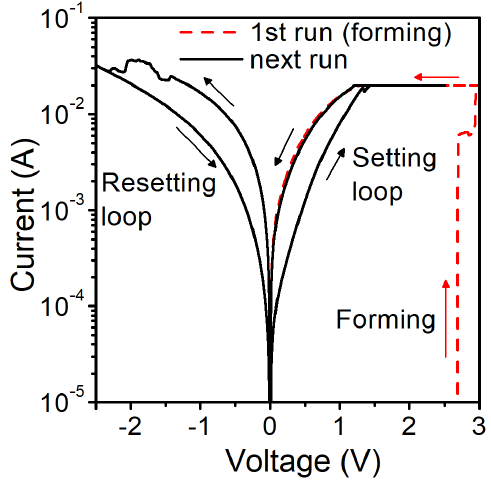
Figure 3. Measured current-voltage characteristics of Al/SiO2/n++ Si RRAM structure S1 with a gate diameter of 156 μm and CC = 20 mA.